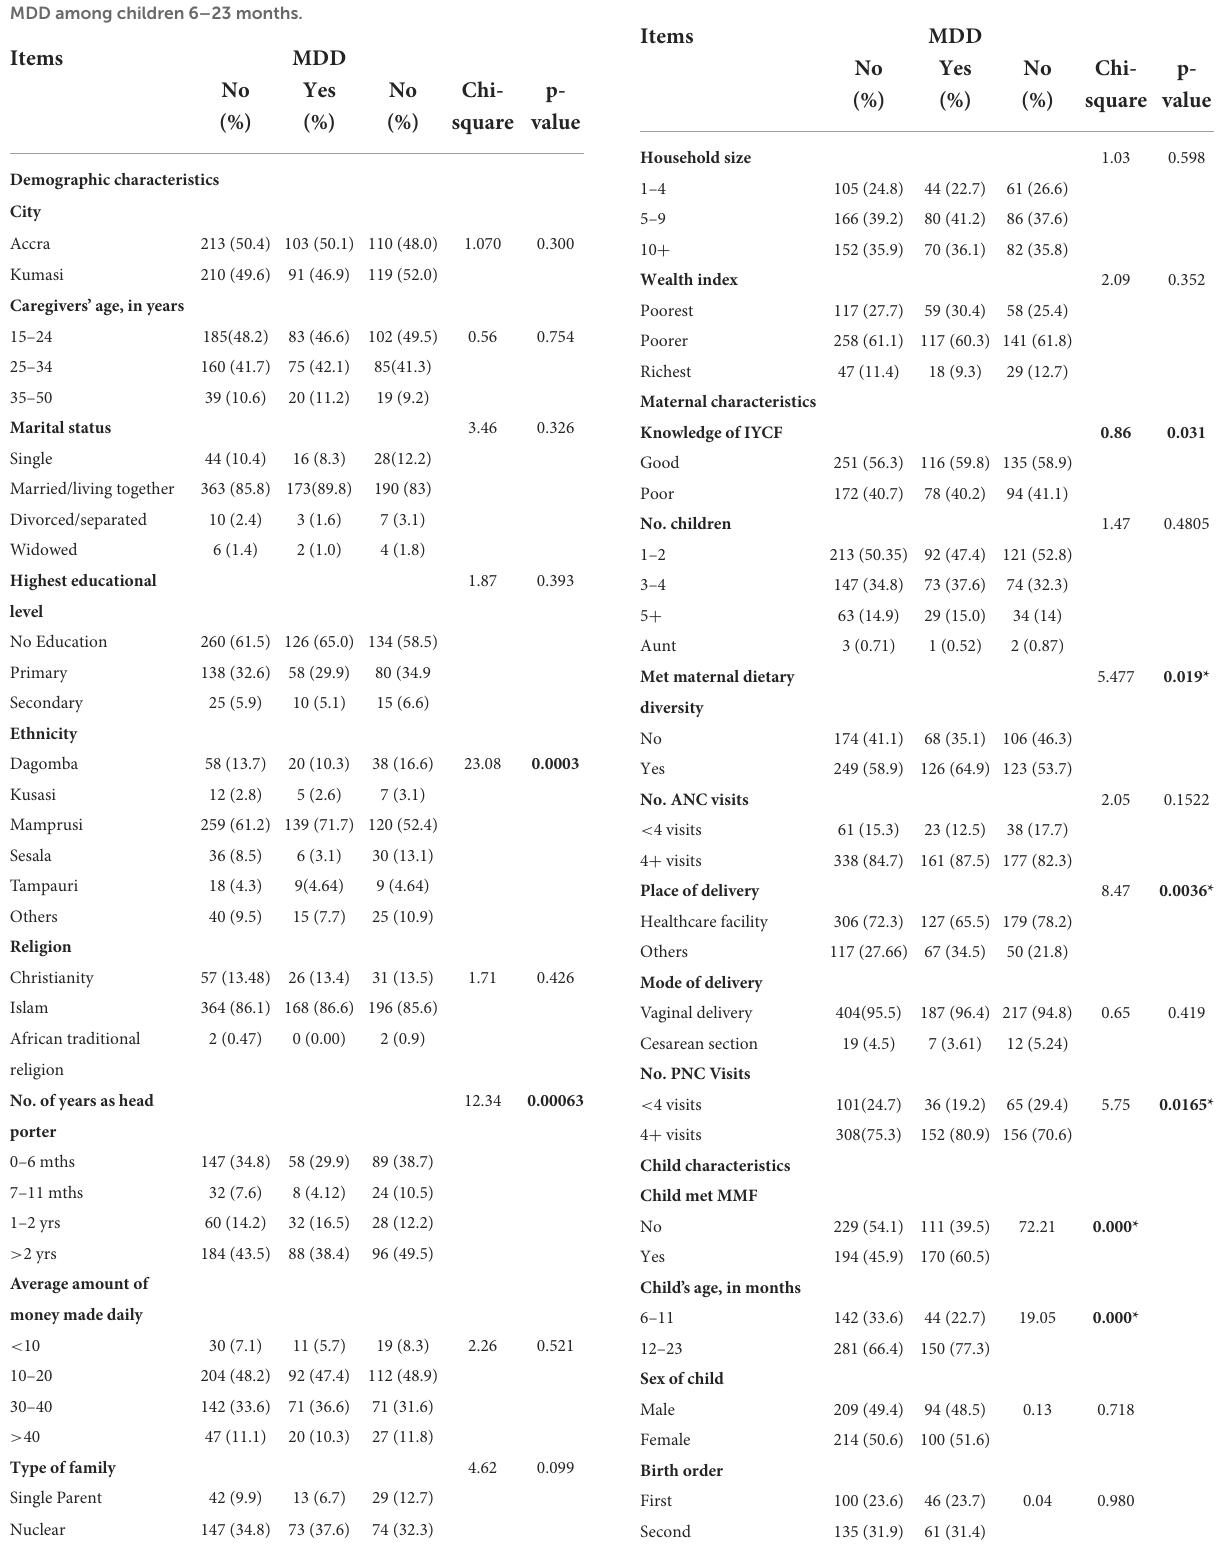
TABLE 4 Association between maternal and child characteristics and MDD among children 6–23